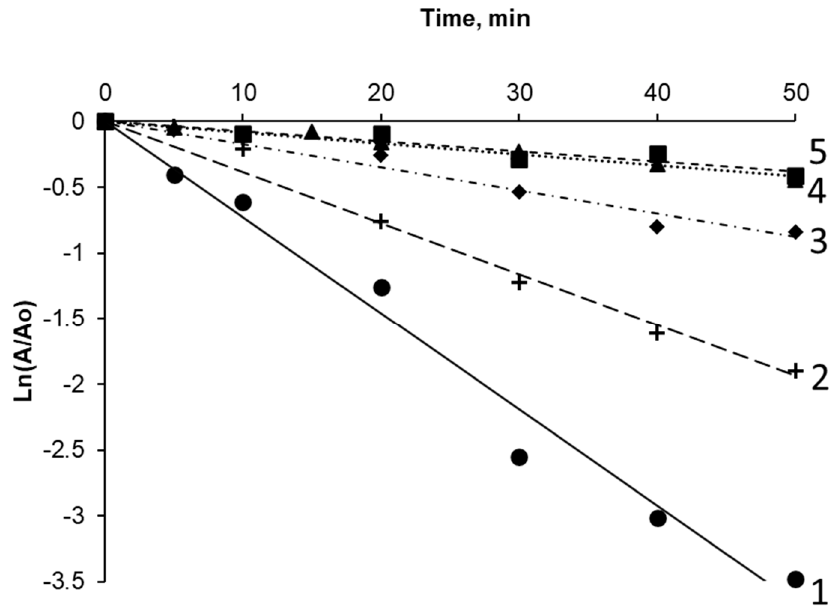
Figure 7. Semilogarithmic dependence of hydrolysis activity of 20 mM L-asparagine after incubation with 0.0025 mg/mL trypsin at 37 ◦ C for 1 mg/mL native RrA ( 1 ) and conjugates: RrA-chitosan-glycol ( 2 ), RrA-chitosan-PEG 7_23 ( 3 ), RrA-chitosan-PEI ( 4 ), and RrA-PEI ( 5 ). Table 7. Values of the trypsinolysis rate (inhibition constant, K in ) for the RrA conjugates. Preparation Native